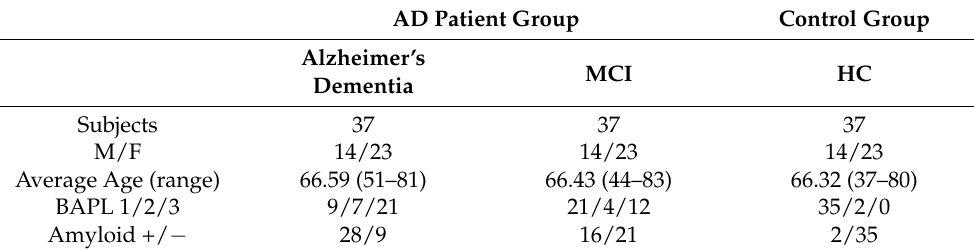
Figure 2. Dual-phase FBB images of subjects. The time range for dFBB is 90–110 min, and the time